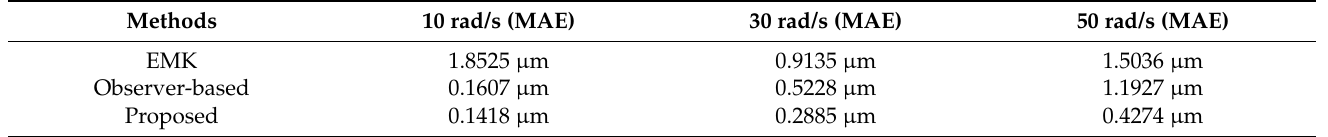
Figure 15. Experimental results of the three control methods (50 rad/s). Table 2. The mean absolute errors (MAEs) of the three control